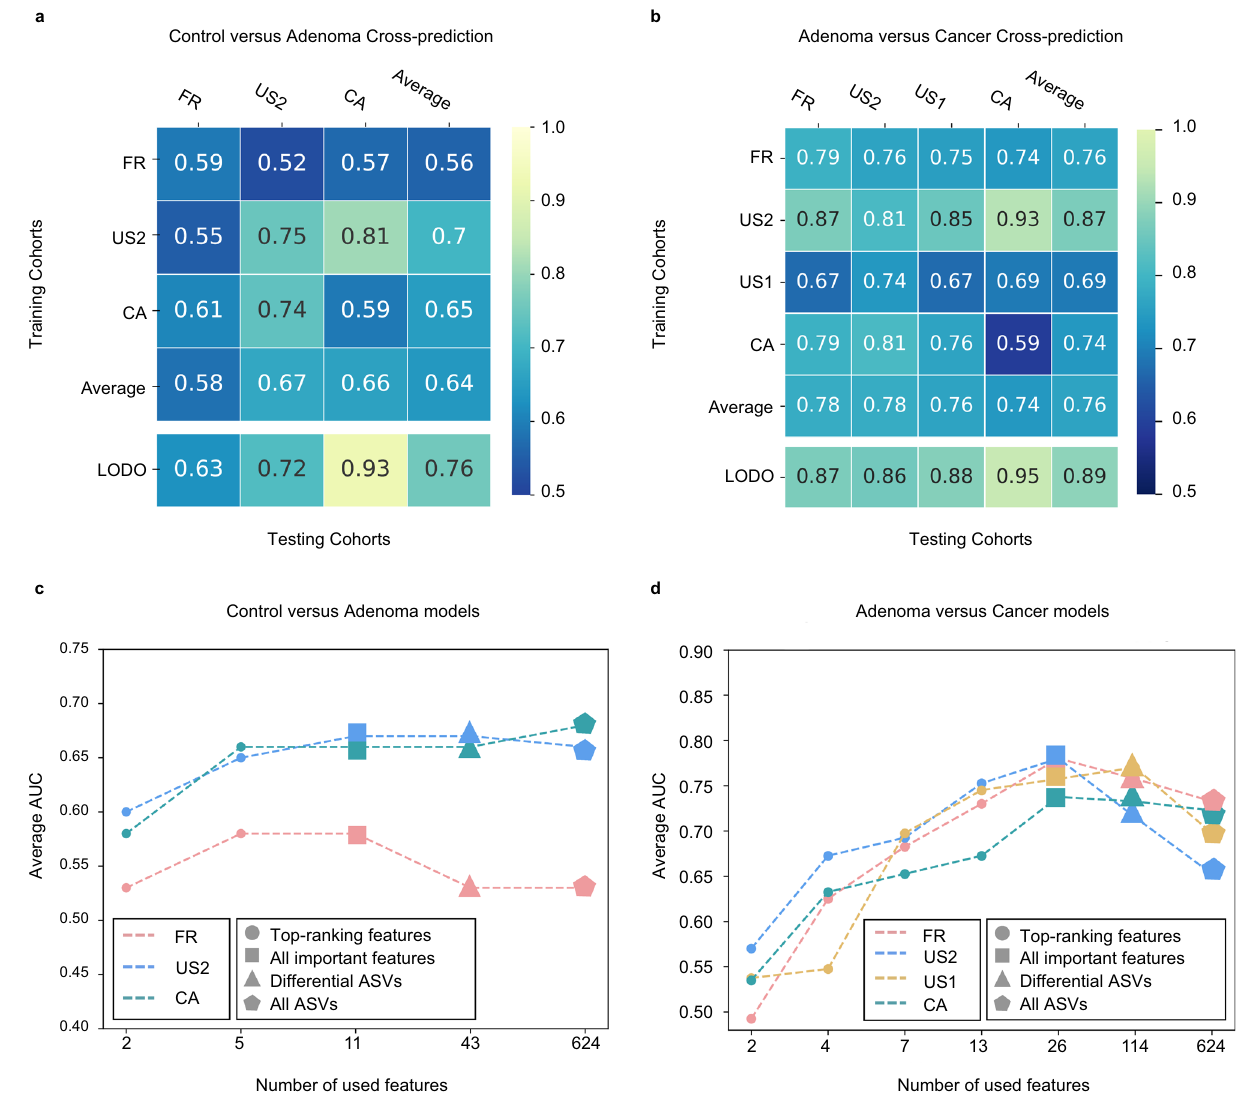
Fig. 3 Prediction performance of important features across studies and identi fi cation of minimal features for detecting adenoma. a , b , Cross-prediction matrix detailing prediction values for differentiating adenoma from control using bagging K-Nearest Neighbors classi fi ers ( a ) and CRC using RF models ( b ) as AUC obtained using important features. Values on the diagonal refer to the results of cross-validation within each study. Off-diagonal values refer to the AUC values obtained from cross-cohort validation, which training the classi fi er on the study of the corresponding row and applying it to the study of the corresponding column. The LODO values refer to the performances obtained by training the classi fi er using all but the study of the corresponding column and applying it to the study of the corresponding column (see “ Model evaluation ” section). The study-to-study and LODO validation values for differentiating adenoma from control using RF models can be found at Supplementary Fig. 9. c , d Average AUC of study-to-study transfer validation classi fi ers for control versus adenoma ( c ) and adenoma versus cancer ( d ) with different sets of features. Input features were indicated as different shapes, top-ranking features, all important features signed, differential ASVs and all ASVs were represented by circles, squares, triangles, and pentagons, respectively. The x axis in c and d indicate different numbers of features. Colors represent different studies. Source data are provided as a Source Data fi